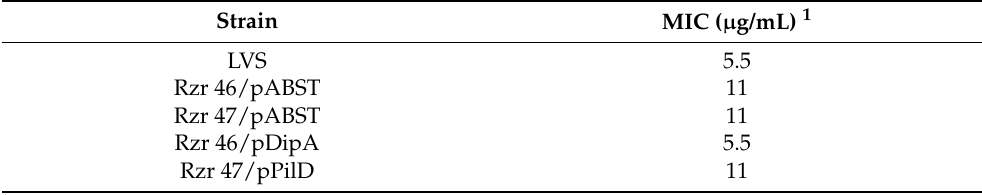
Table 3. Resazurin MIC for dipA and pilD complemented F. tularensis resazurin-resistant